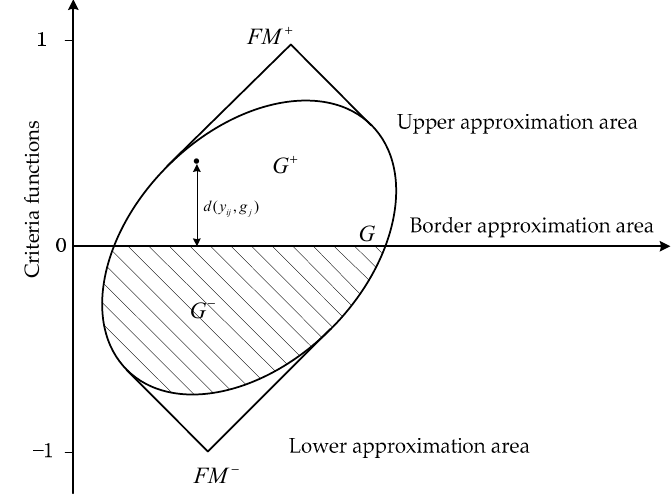
G G + G − , , and . FM: failure mode.